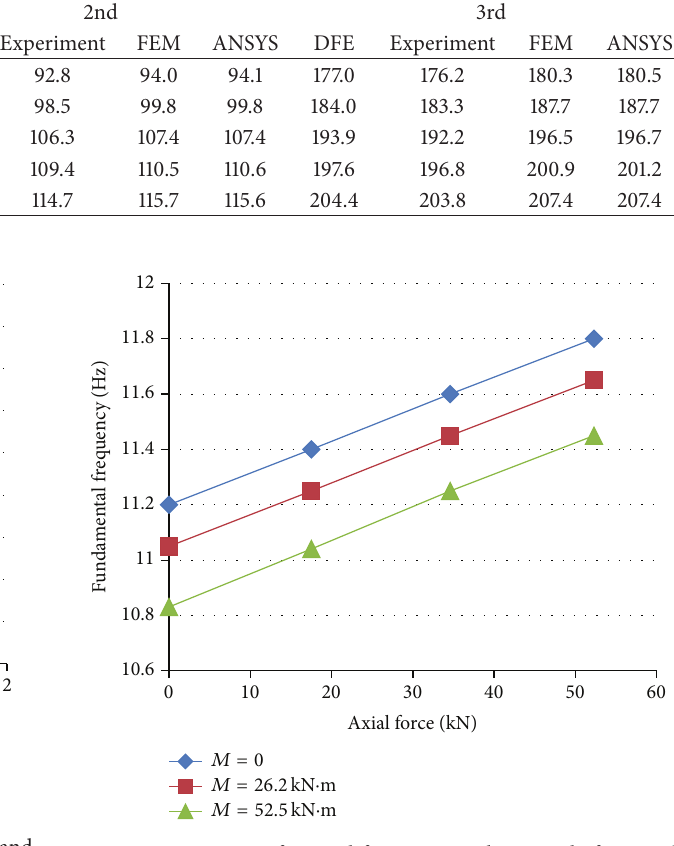
Figure 8: Variation of natural frequencies when tensile force and end moment are applied for pinned-clamped boundary condition.